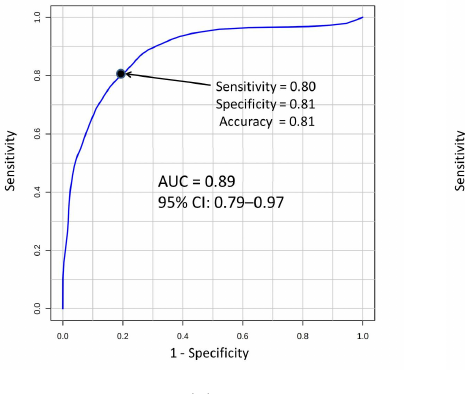
T1D ‐ DN1 group) included 9 metabolites (creatinine, L ‐ proline, L ‐ cysteine, N ‐ formyl ‐ L ‐ aspartate, 1 ‐ methylhistidine, oxalosuccinic acid, N ‐ acetyl ‐ b ‐ glucosaminylamine, N2 ‐ succinyl ‐ L ‐ ornithine, and 3 ‐ carboxy ‐ 4 ‐ methyl ‐ 5 ‐ propyl ‐ 2 ‐ furanpropionic acid), and was characterized by AUC =